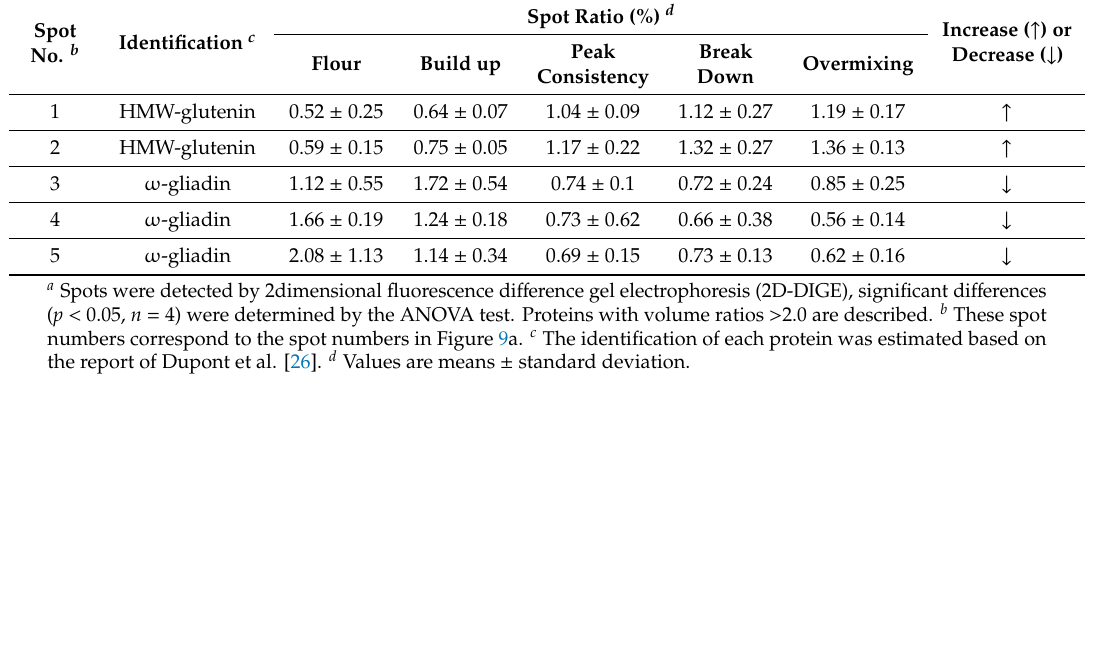
Figure 9. Electrophoretic images of the protein aggregates ( a , c ) and monomeric protein ( b , d ) in high protein ( a , b , HF) and low protein flour ( c , d , LF). Blue circles show protein spots whose intensities decreased during mixing ( n = 4. p < 0.01, volume ratio > 2.0). Red circles show protein spots whose intensities increased during mixing ( n = 4, p < 0.01, volume ratio > 2.0). Each spot number corresponds to the spot number in Tables 1–4. Table 1. Decreased and increased proteins in protein aggregates in HF a during mixing.